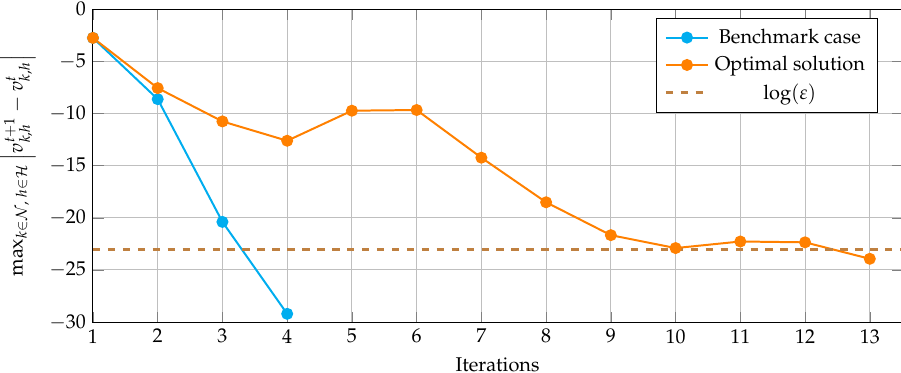
Figure 4. Evolution of the convergence error for the proposed